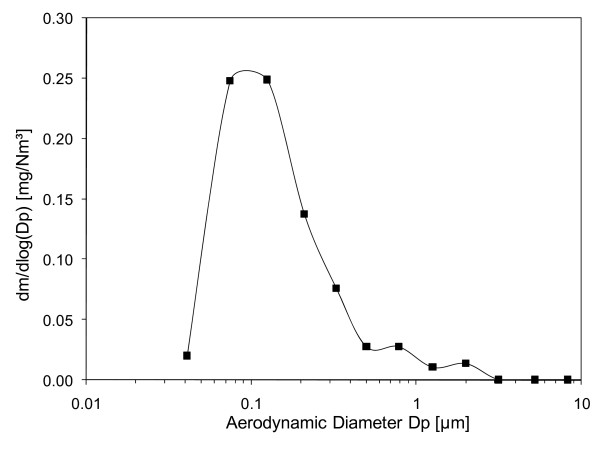
Mass size distribution of diluted diesel exhaust particles in the exposure chamber during the urban running part of the European Trancient Cycle. MMDa for the fine mode was 0.116 μm.